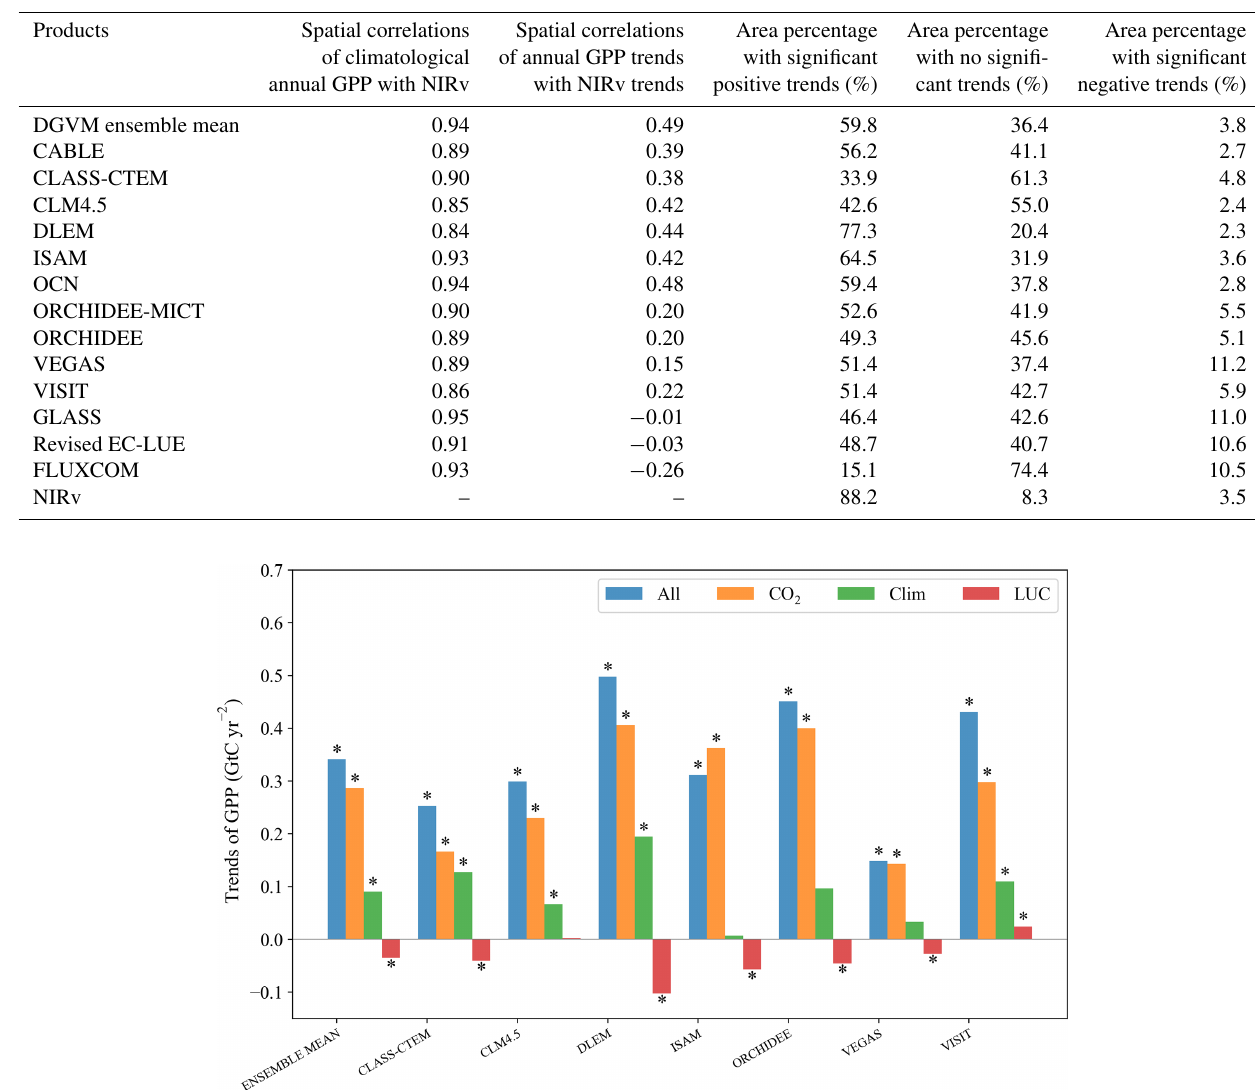
Figure 4. Attributions of global total GPP trends for TRENDYv6 simulations from 1982 to 2015: CO 2 fertilization effect (S1), climate (S2 – S1), and land-use change (S3 – S2). “All” gives the values of the reference simulation that includes the effect of all three drivers (S3). Asterisks indicate that the trend is significant with p < 0 . 05 following the non-parametric Mann–Kendall trend test.